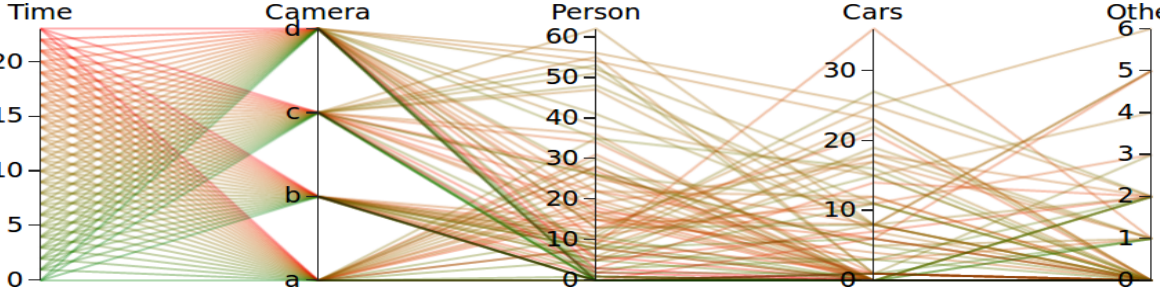
Figure 7. Visual exploration of our four cameras with parallel coordinates visualization technique (best seen in